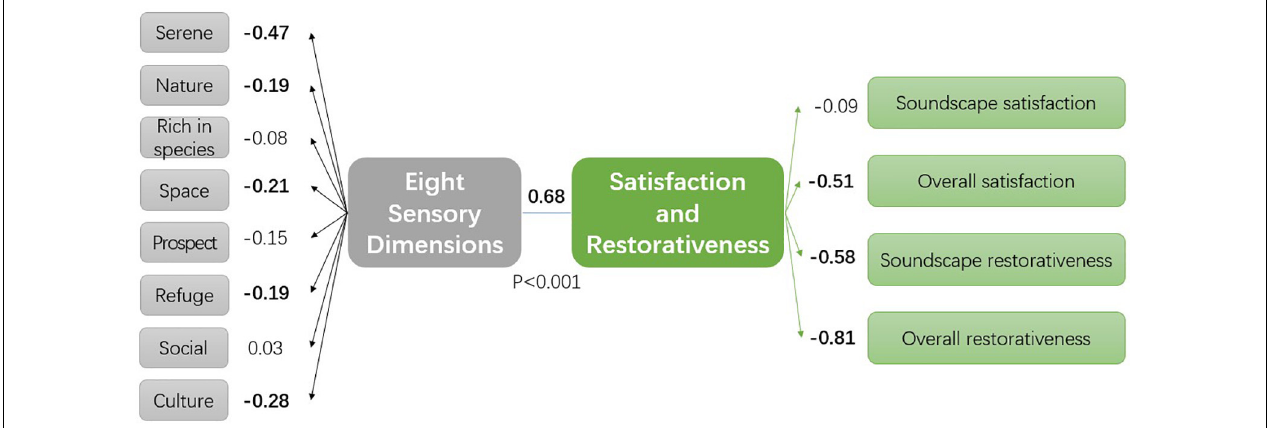
FIGURE 3 | A model of the canonical correlation analysis for the eight sensory dimensions and satisfaction and restorativeness. Included are the value of the first canonical correlation and the values of the significant unstandardized